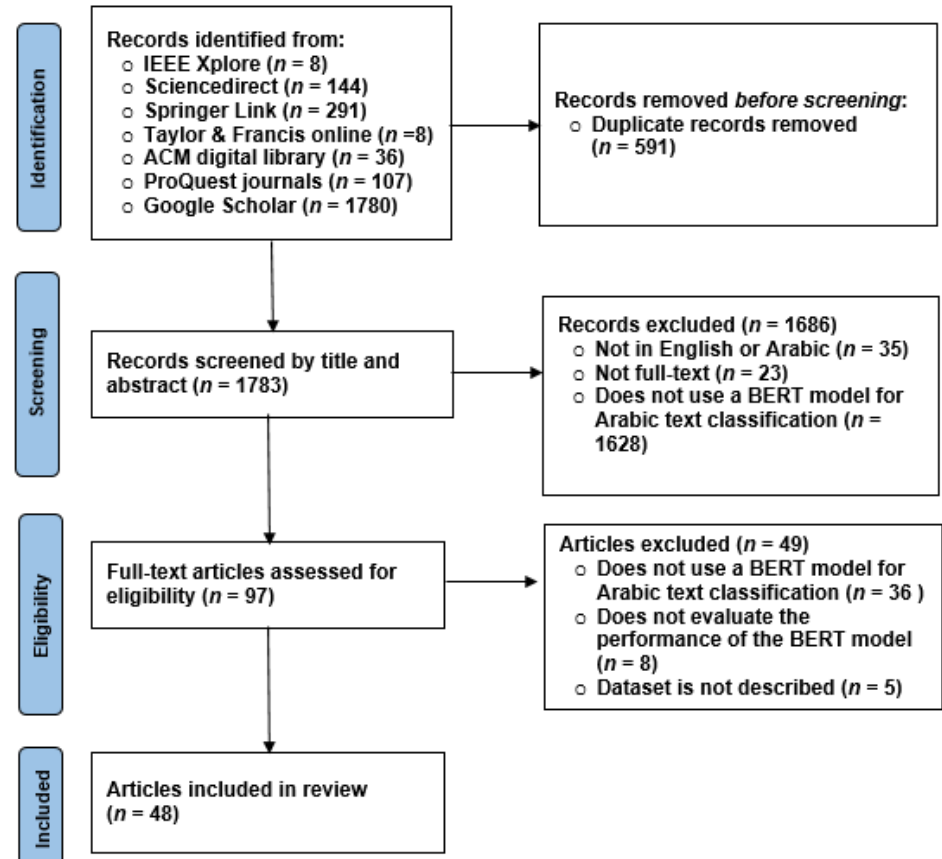
Figure 1. The systematic review process.